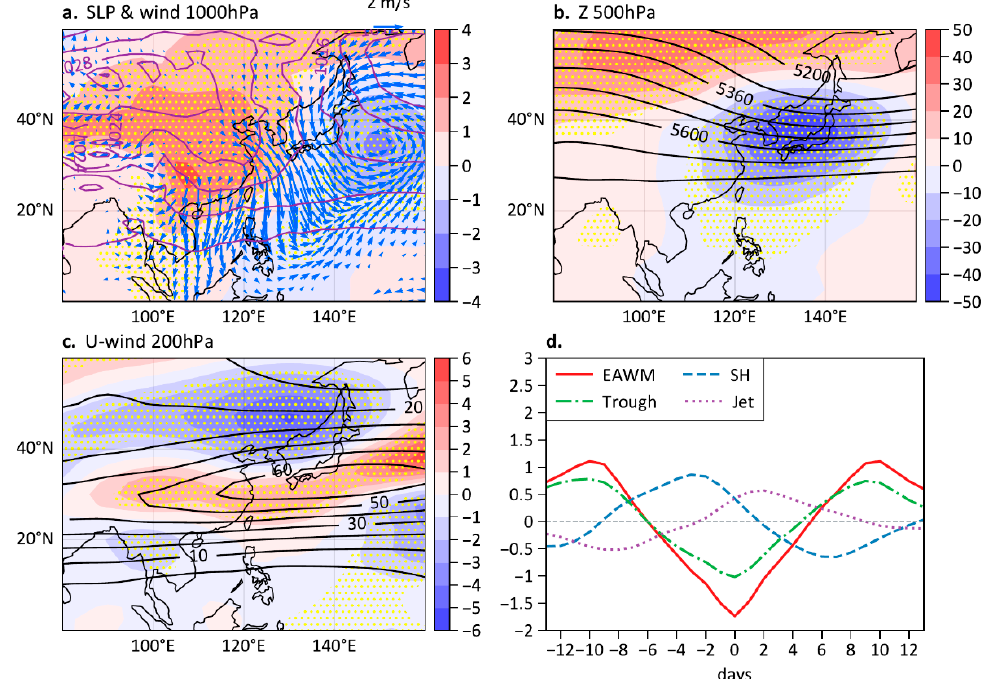
Figure 2. Composite anomalies of ( a ) surface level pressure (SLP, hPa) and 1000 hPa wind (m s − 1 ); ( b ) 500 hPa geopotential height (gpm); and ( c ) 200 hPa zonal wind (m s − 1 ) for day 0 of the strong EAWM events. Stripping in ( a – c ) indicates the anomaly values exceed the 95% confidence level. ( d ) Evolutions of the composite EAWM index (red line, denoted as EAWM), Siberian High index (blue dashed line, denoted as SH), East Asian trough index (green dashed line, denoted as Trough), and East Asian jet stream index (purple dotted line, denoted as Jet) during the strong intraseasonal EAWM events.